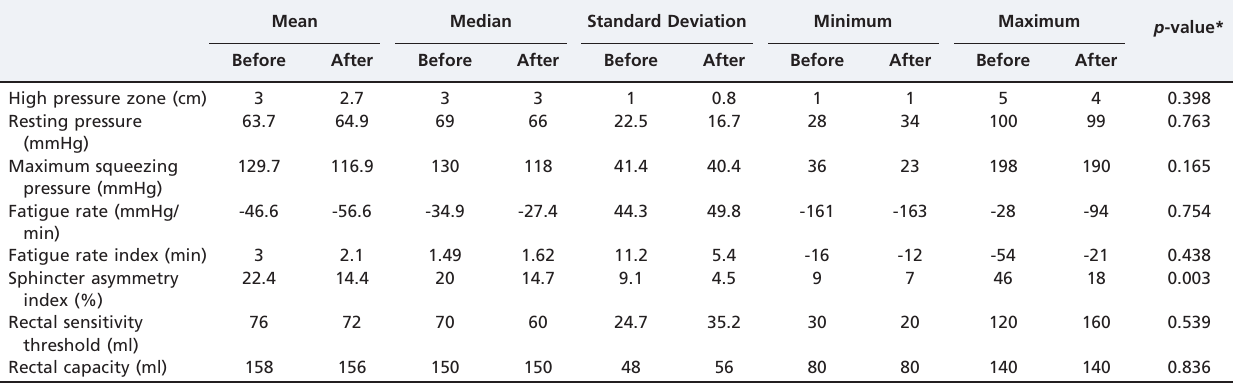
Table 1 - Anorectal manometry parameters in patients before and after perineal prostatectomy. Mean Median Standard Deviation Minimum